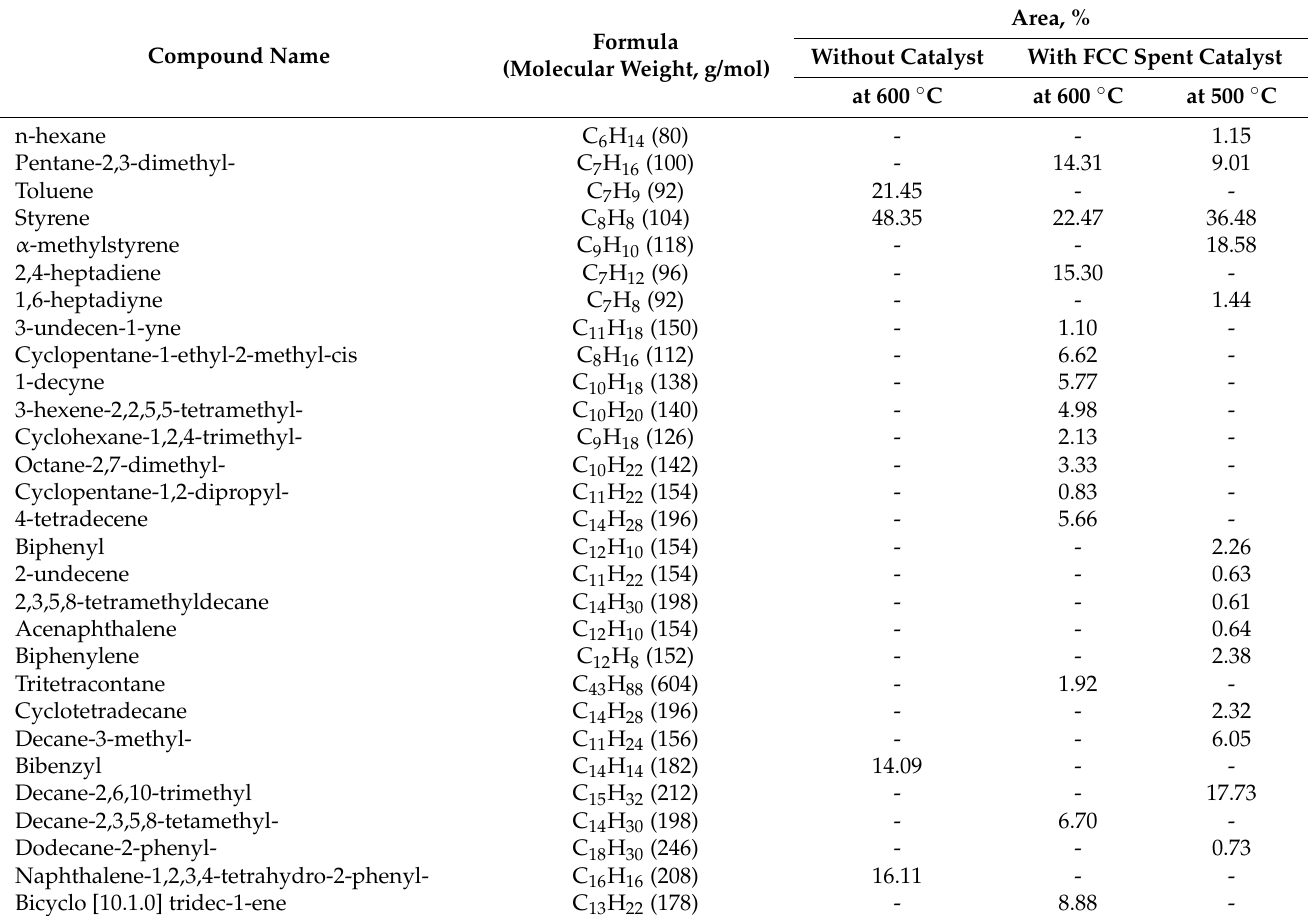
Table 5. Analysis of packaging materials by Py-GC/MS with and without FCC spent